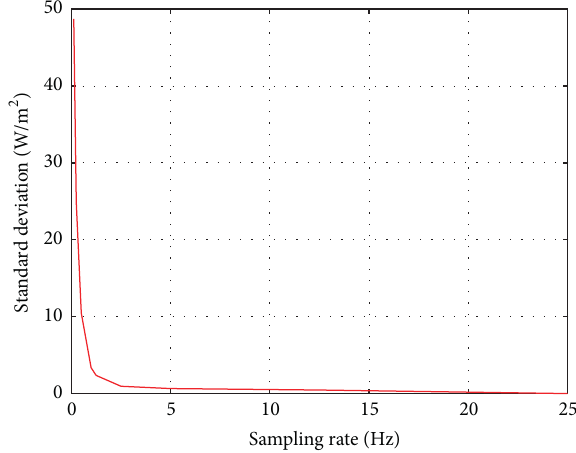
Figure 5: Standard deviation error of the incoming solar radiation as a function of the sampling frequency on a single PV module during a period of 7 hours on July 1st,